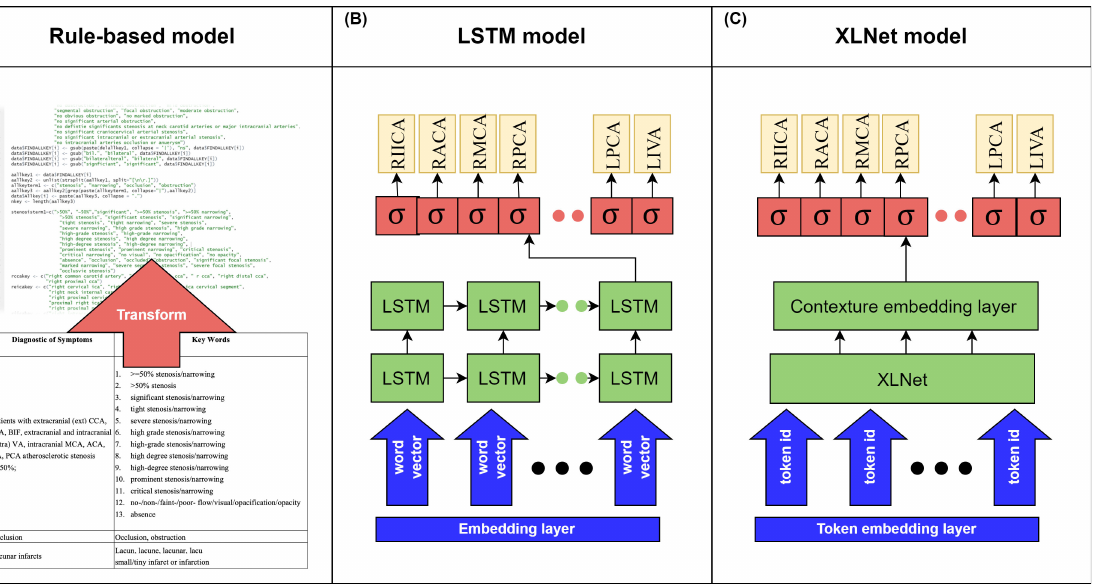
Figure 1. Overview of stenosis identification models. Panel A presents a rule-based model, which is a handcrafted feature-based approach. Panel B presents a long short-term memory model, which is a recurrent neural network approach. Panel C presents XLNet, which is a pretrained language model